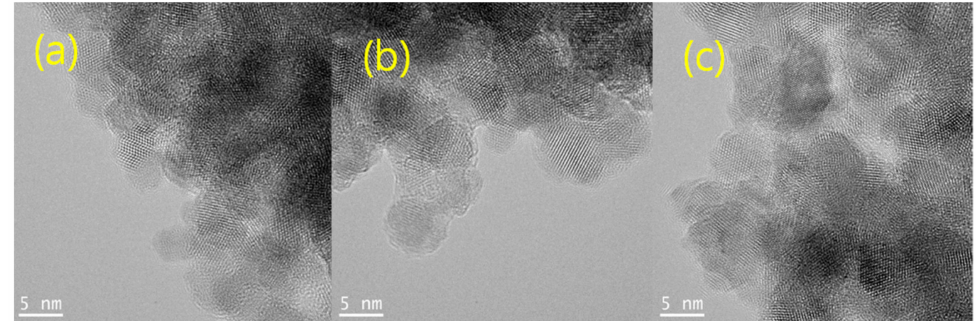
Figure 2. HR-TEM images of: ( a ) Gly-ZnS:Mn, ( b ) Ala-ZnS:Mn, and ( c ) Val-ZnS:Mn